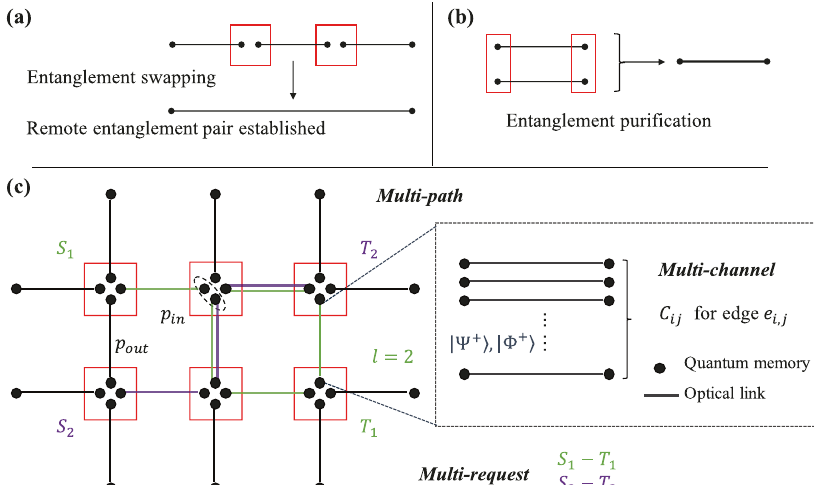
Fig. 1 Routing problem statement. a Diagram of entanglement swapping. Two remote stations can be entangled with the assistance of intermediate nodes. Black dots (lines) represent quantum memories (optical links). b Diagram of entanglement puri fi cation. With local physical operations and communication through classical channels, an entangled pair with high fi delity can be distilled from two fresh pairs with lower fi delity. c Entanglement routing on a 2D square lattice network. Edge ( i , j ) consists of multiple entangled pairs (multi-channels) such as Bell states, whose capacity is denoted as C ij . Entanglement generation between S 1(2) and T 1(2) is requested and multiple paths are identi fi ed for each request. The probabilities of successfully building an entangled pair between adjacent nodes and performing local Bell state measurement are denoted as p out and p in ,